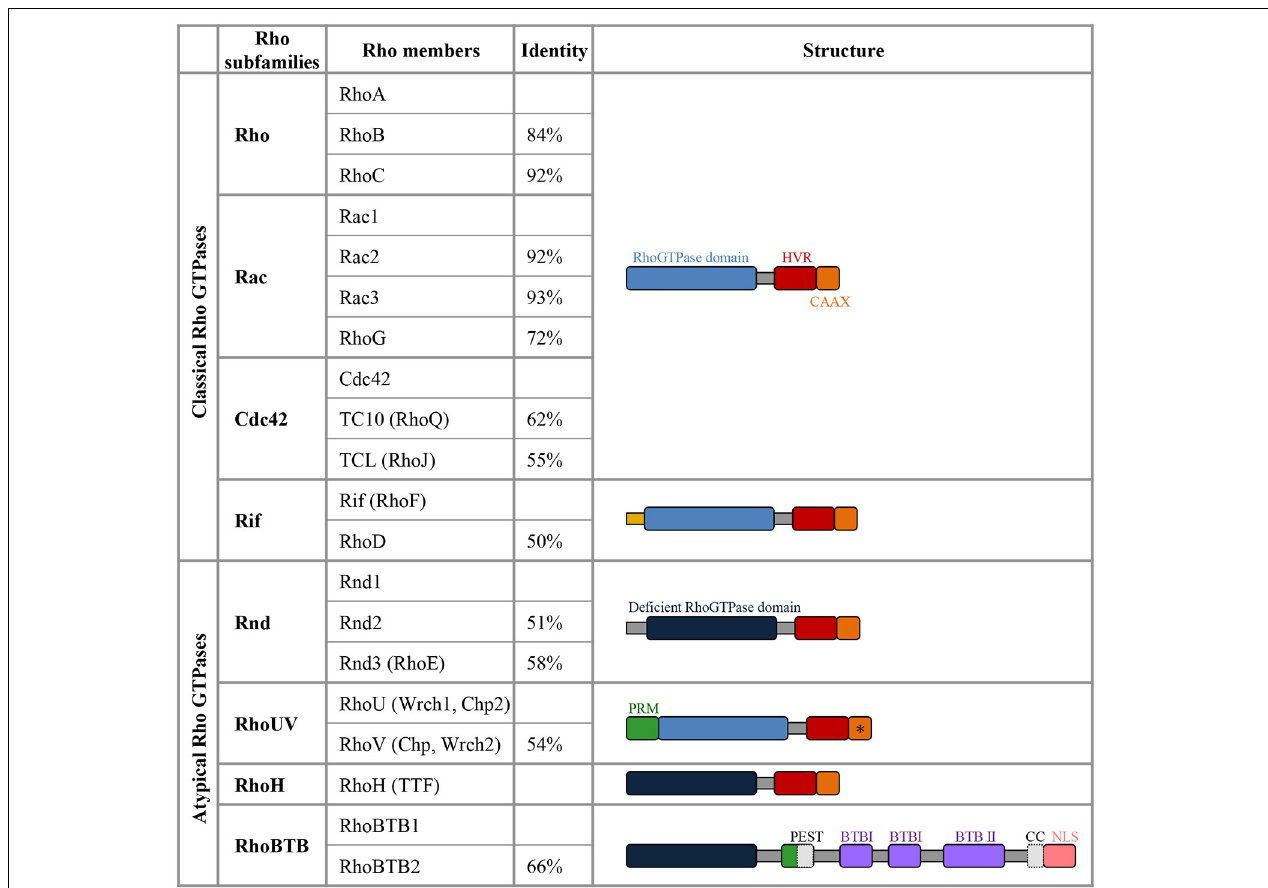
FIGURE 1 | Members of the Rho GTPase family. The column identity indicates the percentage of amino-acid sequence identity of a specific Rho GTPase compared with the first member of the corresponding subfamily (Heasman and Ridley, 2008). Among the atypical members, Rnd1, Rnd2, Rnd3, RhoH, RhoBTB1, and RhoBTB2 lack amino acids in the GTPase domain that are critical for GTPase activity, they are thus constitutively bound to GTP and do not detectably hydrolyse GTP (deficient Rho GTPase domain in dark blue). RhoV and RhoU harbor GTPase activity but they are atypical in this family as they display a high intrinsic guanine nucleotide exchange activity and are predominantly in the GTP-loaded conformation. In the C-terminal domain, the Hyper Variable Region (HVR in red) differs not only between the Rho GTPase subclasses but also within the same subclass in terms of the presence of either a polybasic region or a palmitoylation site (Roberts et al., 2008). The polybasic region and palmitoylation site present in the HVR are involved in targeting the GTPases to plasma membrane or